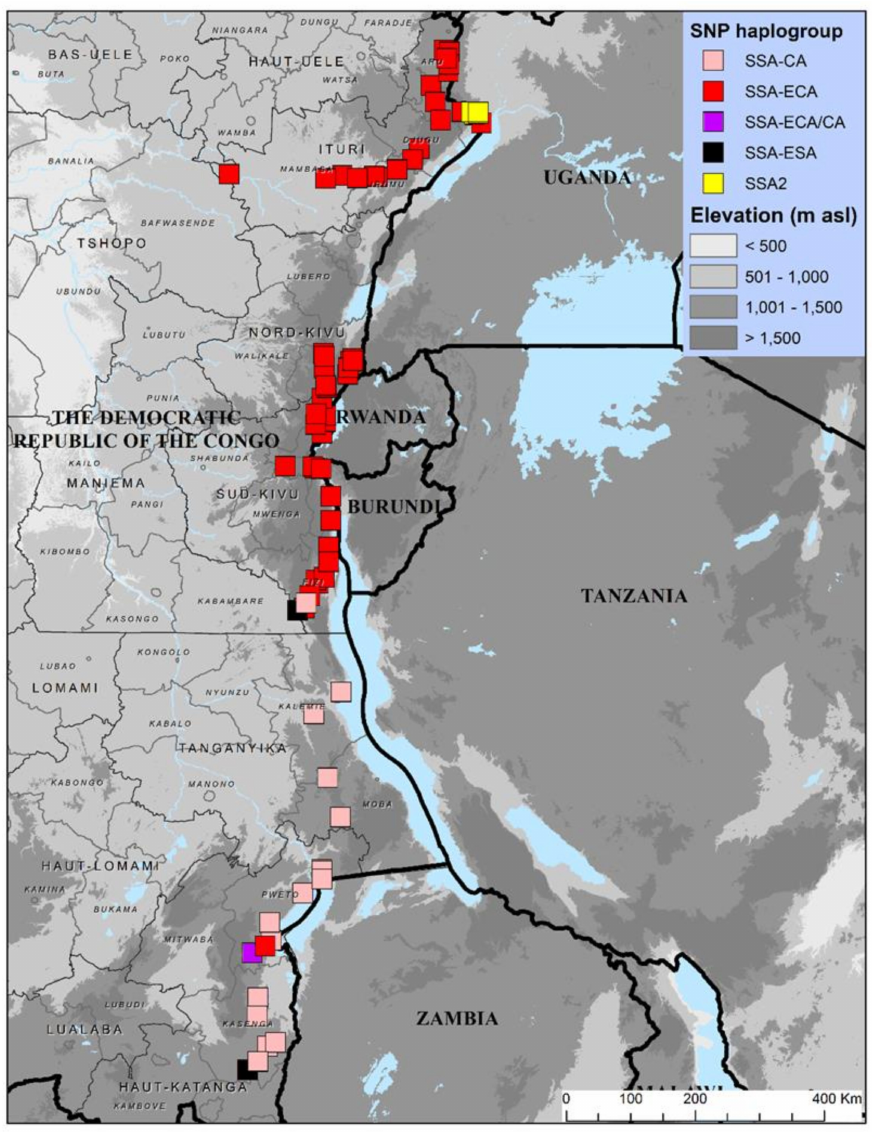
Figure 2. Geographic distribution of cassava-colonizing Bemisia tabaci whiteflies in provinces sur- veyed in 2016 and 2018 in eastern Congo, based on KASP SNP